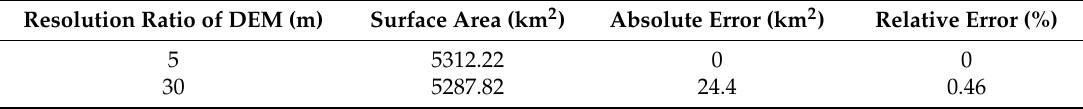
Figure 8. DEMs of Nanjing, Dongying, and Changdu. Table 4. Comparison of surface area calculation methods between this study and the literature. Region